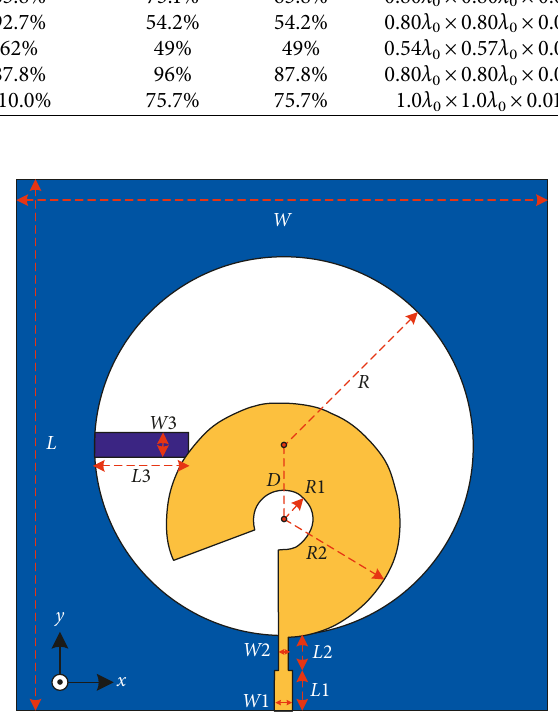
Figure 1: Geometry of the designed slot CPA.